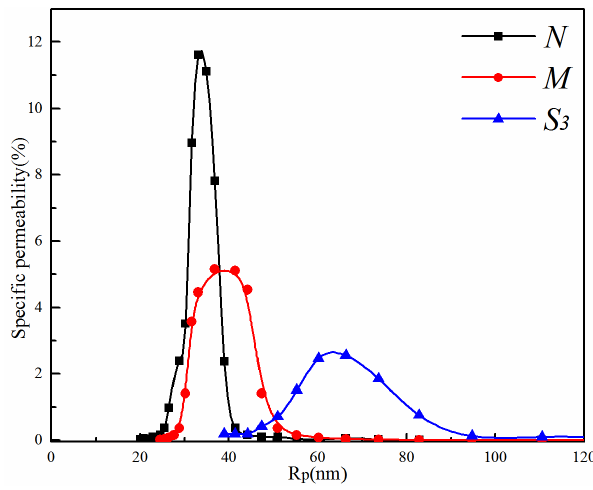
Figure 9. Pore size distribution curves of membranes N , M and S 3 (total polymer concentration of 20 wt %). Table 3. Mean pore size of membranes N , M and S 3 .